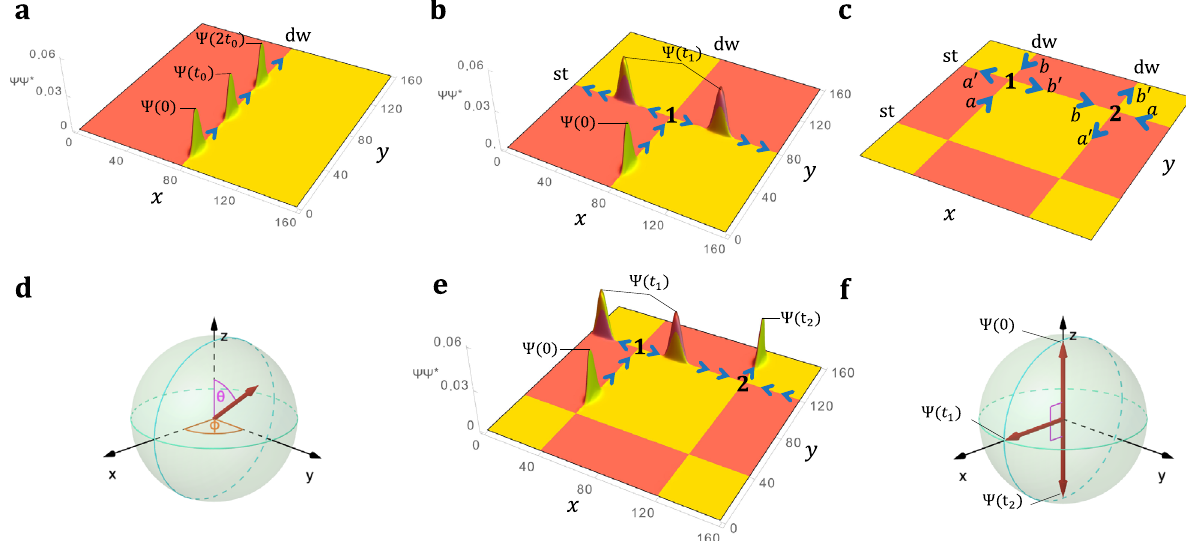
Fig. 3 Effective description of wave packet (WP) time evolution. a Snapshots of the WP showing the propagation on the domain-wall channel. b A WP scatters at Junction 1 and splits into two spatially separated outgoing components of the wavefunction. c Channel labeling convention for Junction 1 and 2. d Qubit representation of a WP state on the Bloch sphere. e The initial WP splits after encountering Junction 1, the two components then meet at Junction 2, interfering destructively on channel a 0 and constructively on channel b 0 . f Qubit representation of the time evolution in ( e ). WP plots in ( a ), ( b ), ( e ), are calculated from the (001)-projected probability densities at different times. Time-evolution animations of the WPs in ( a ), ( e ) are shown Supplementary Movies 1,